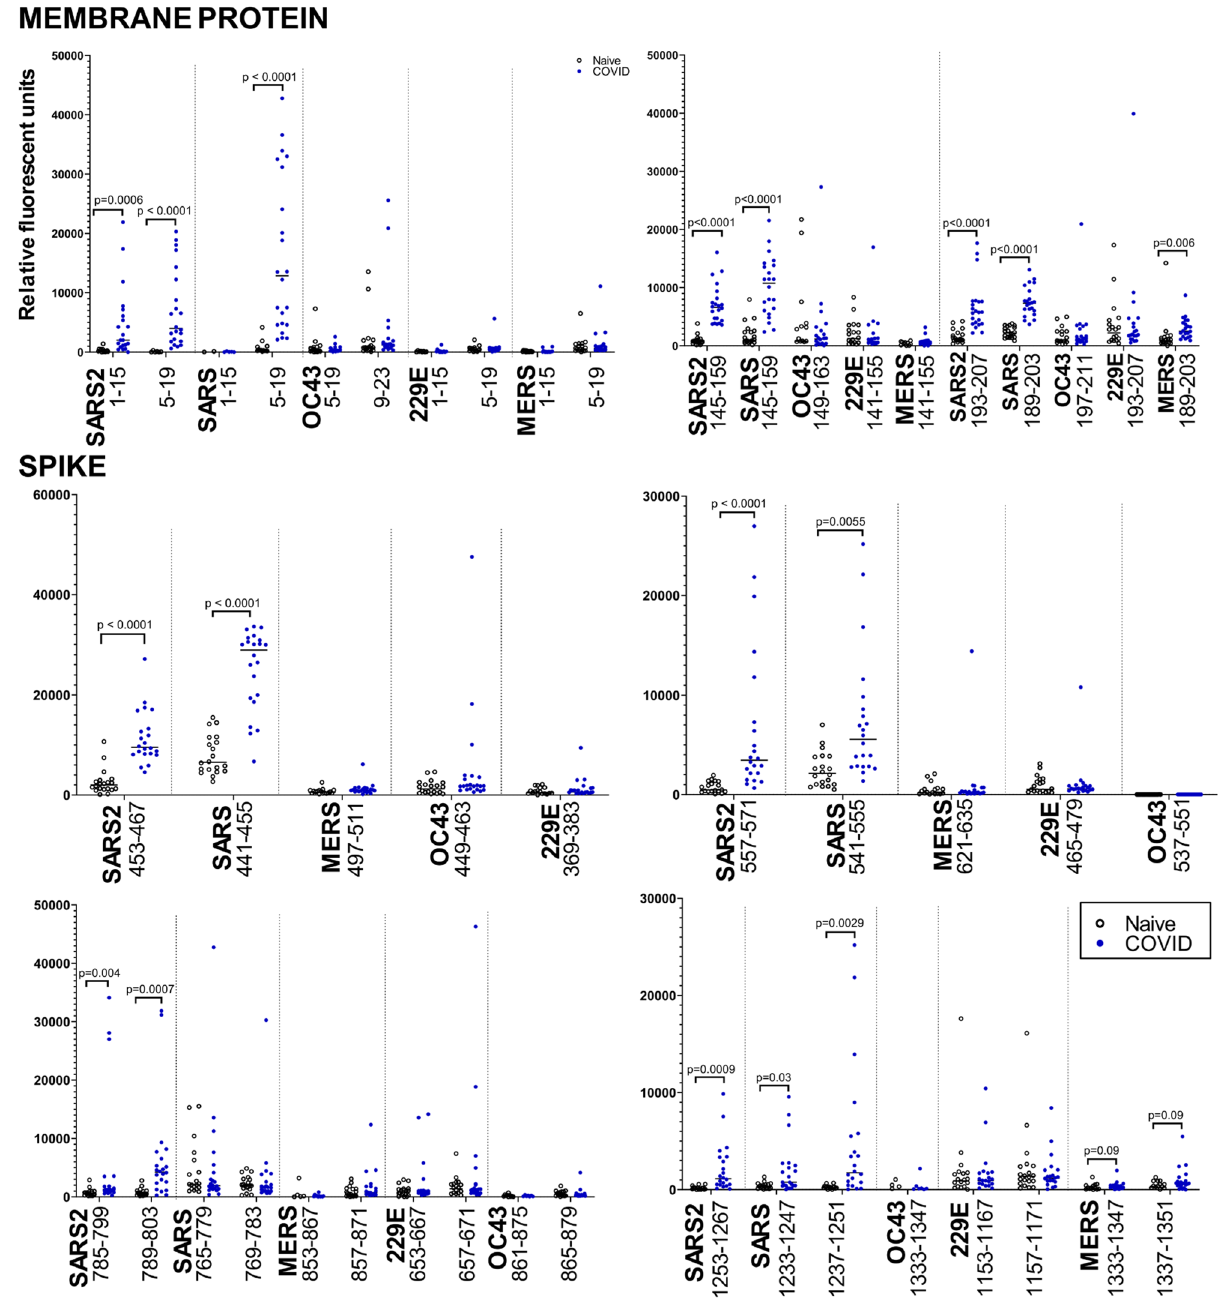
Figure 5. Immunodominant SARS-CoV-2 epitopes are highly specific and discriminatory, and exhibit minimal cross-reactivity to related human coronaviruses beyond SARS-CoV. Data presented for the three immunodominant membrane protein epitopes (peptides 1–19, 145–159, and 193–207), and four spike epitopes (peptides 453–467, 557–571, 785–803, and 1253–1267). Dots represent average signal intensity (relative fluorescent units) for individual samples (open circles, naïve sera, n = 20; blue circles, COVID-19 sera, n = 22). Sequence alignments were used to identify homologous regions in related coronaviruses. P-values were calculated using the Mann–Whitney U test and adjusted for false-discovery using the Benjamini–Hochberg correction. SARS2, SARS-CoV-2; SARS, SARS-CoV; MERS, MERS-CoV; OC43, hCOV-OC43; and 229E,